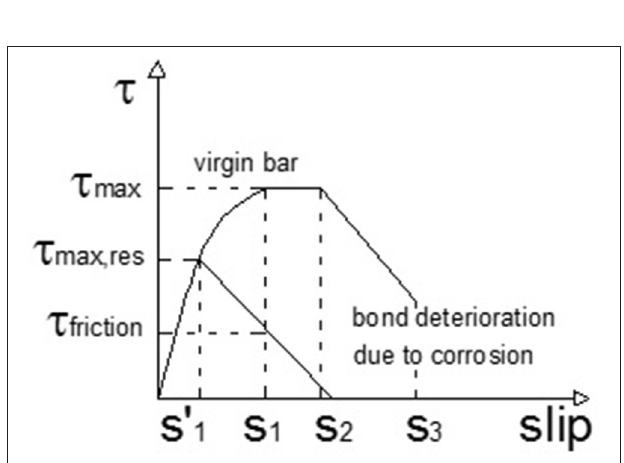
FIGURE 4 | Bond deterioration due to